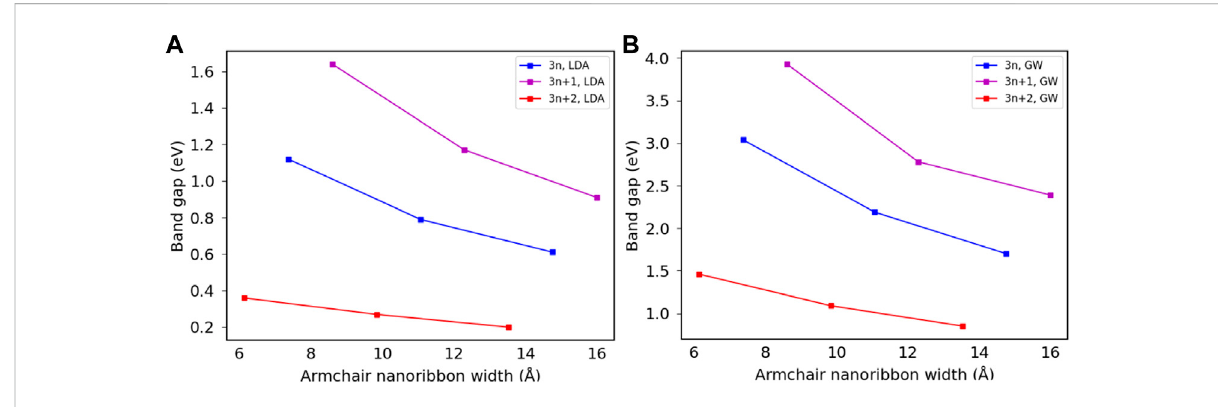
FIGURE 2 Comparison of band gaps of armchair graphene nanoribbons calculated from DFT-LDA and GW approximations. (A) LDA bandgaps. (B) GW bandgaps.